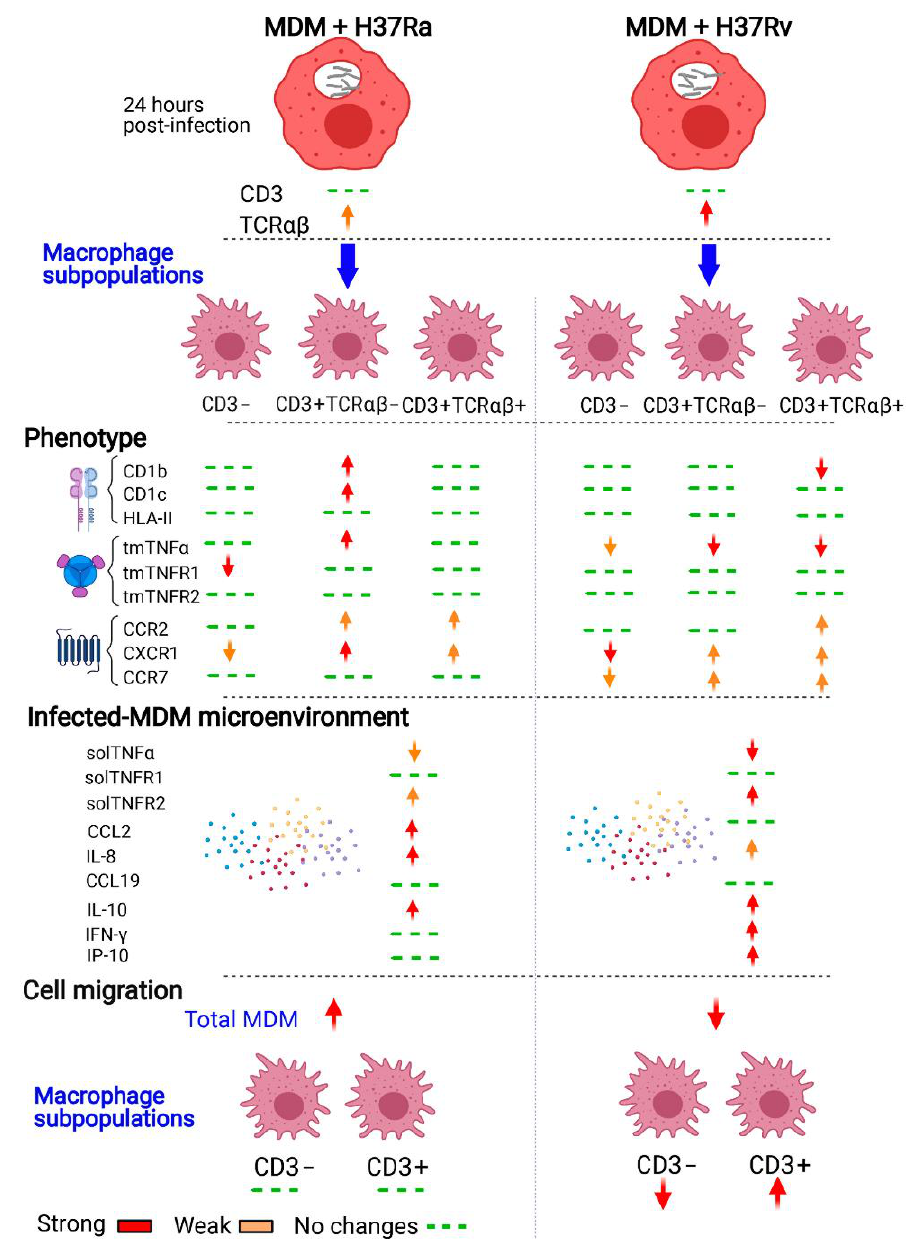
Figure 7 . Schematic representation of the immune response of CD3 + TCRαβ + and CD3 + TCRαβ − myocyte-derived macrophage (MDM) subpopulations to Mycobacterium tuberculosis (Mtb) infection. Human monocytes that are differentiated into macrophages and then infected with the H37Ra or H37Rv Mtb strains display a different phenotype and cytokine microenvironments in response to the infection. CD3 + TCR αβ + and CD3 + TCR αβ − MDM subpopulations show differential expression of molecules of the TNF/TNFRs axis, antigen-presenting molecules of MHC class II, and the CD1 family (of protein and lipid, respectively), and chemokine receptors depending on Mtb virulence. The immunological profile generated by H37Rv infection affects the migration ability of MDMs, but interestingly, the migration ability of CD3 − MDMs is decreased, whereas that of CD3 + MDMs remains intact. The changes are indicated when both MOIs modified the phenotype to simplify the summary of the